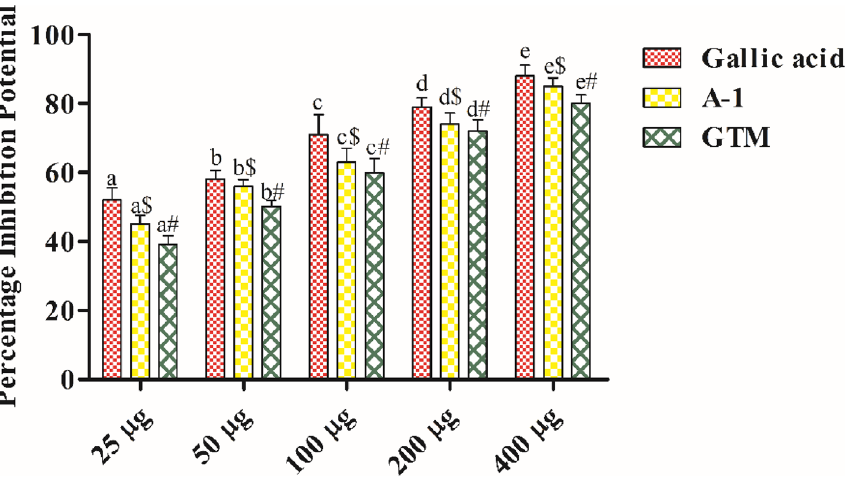
Figure 2. Percentage inhibition potential of Gallic acid, isolated compound and GTM. Data is presented as mean ± SEM. Abbreviations: GTM G. tiliaefolia methanol extract. Data sets with different alphabets differ significantly (p < 0.05) from each other.